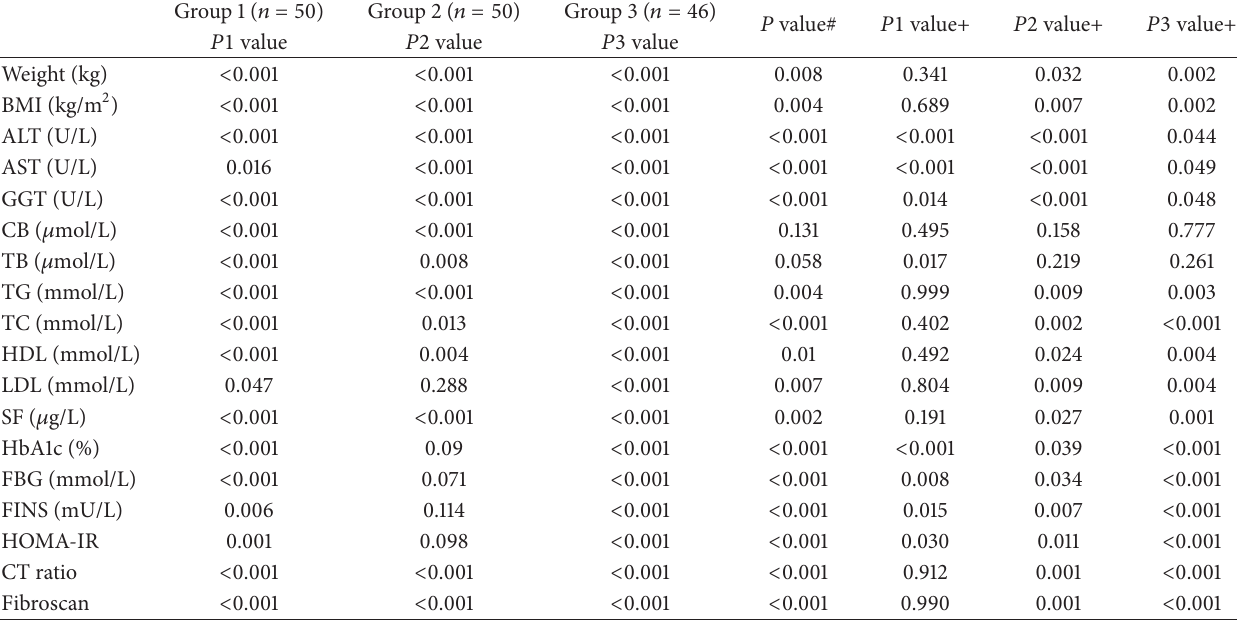
Table 3: Comparisons within groups and between groups in patients with T2DM and NAFLD at 24